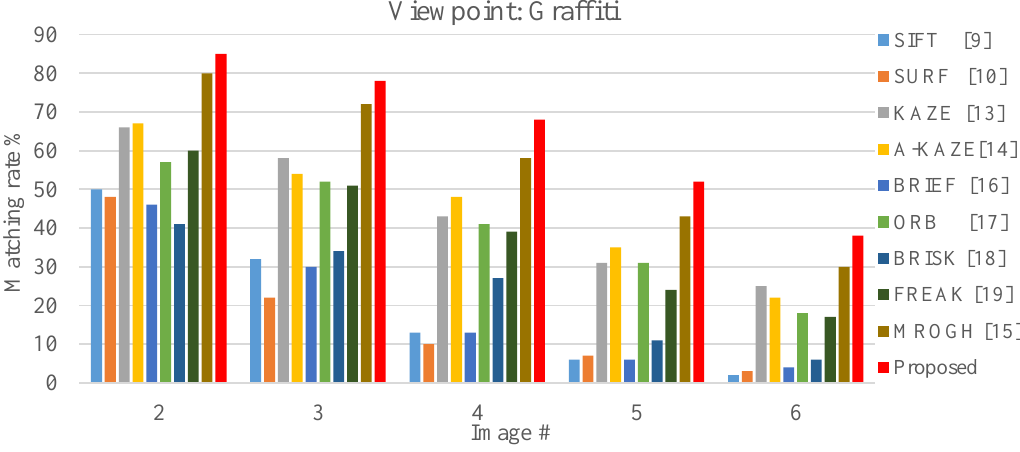
Figure 20. Local stable feature matching outcomes under various view-angles.